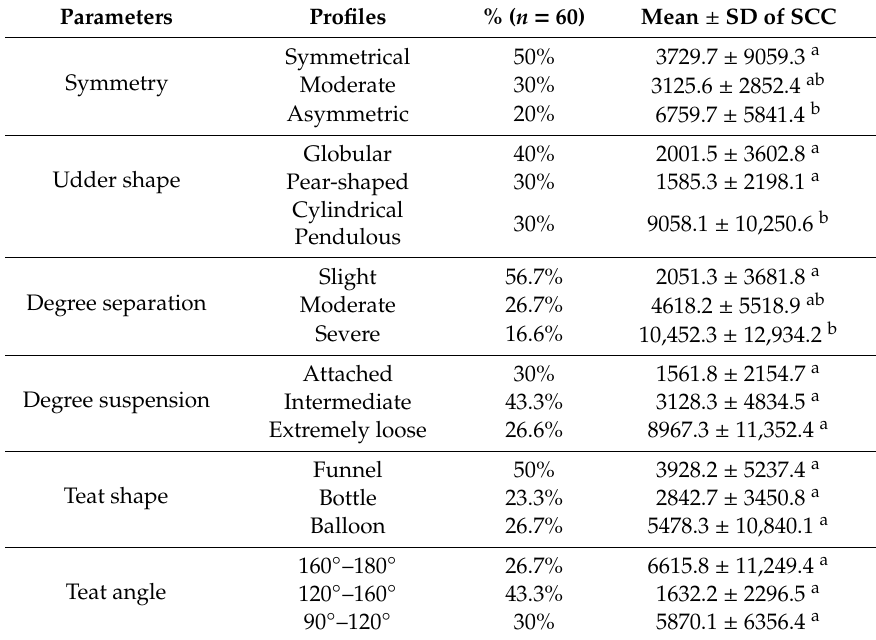
Table 5. Association between mammary morphological traits and somatic cells count (10 3 SC /